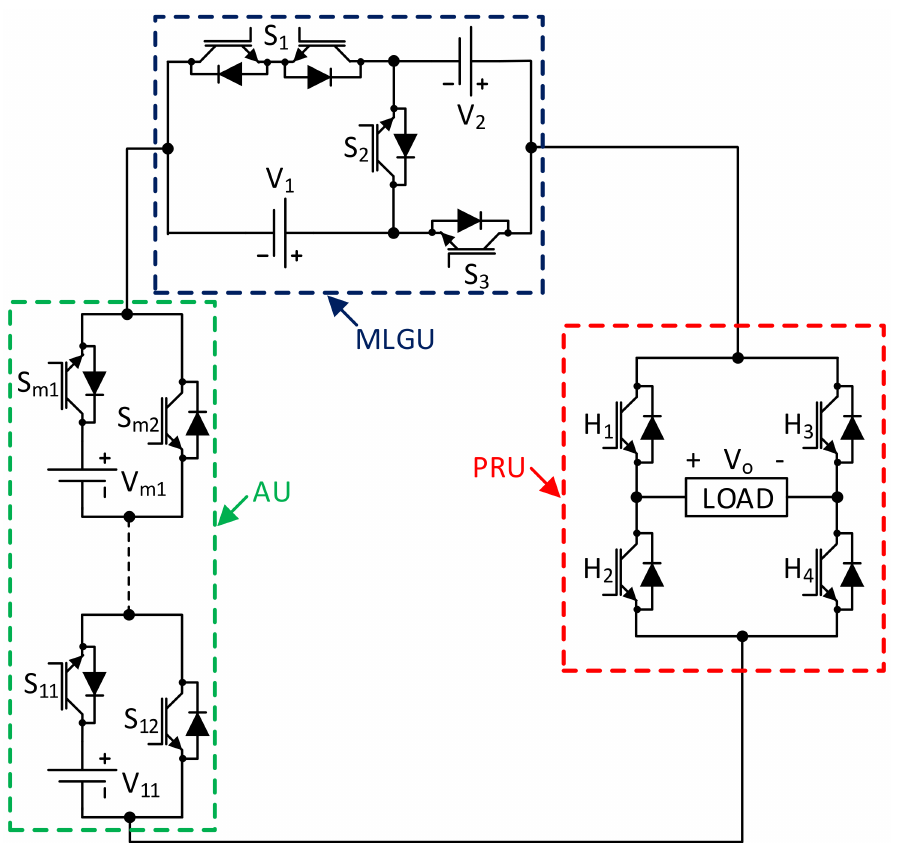
Figure 3. Generalized structure of the proposed